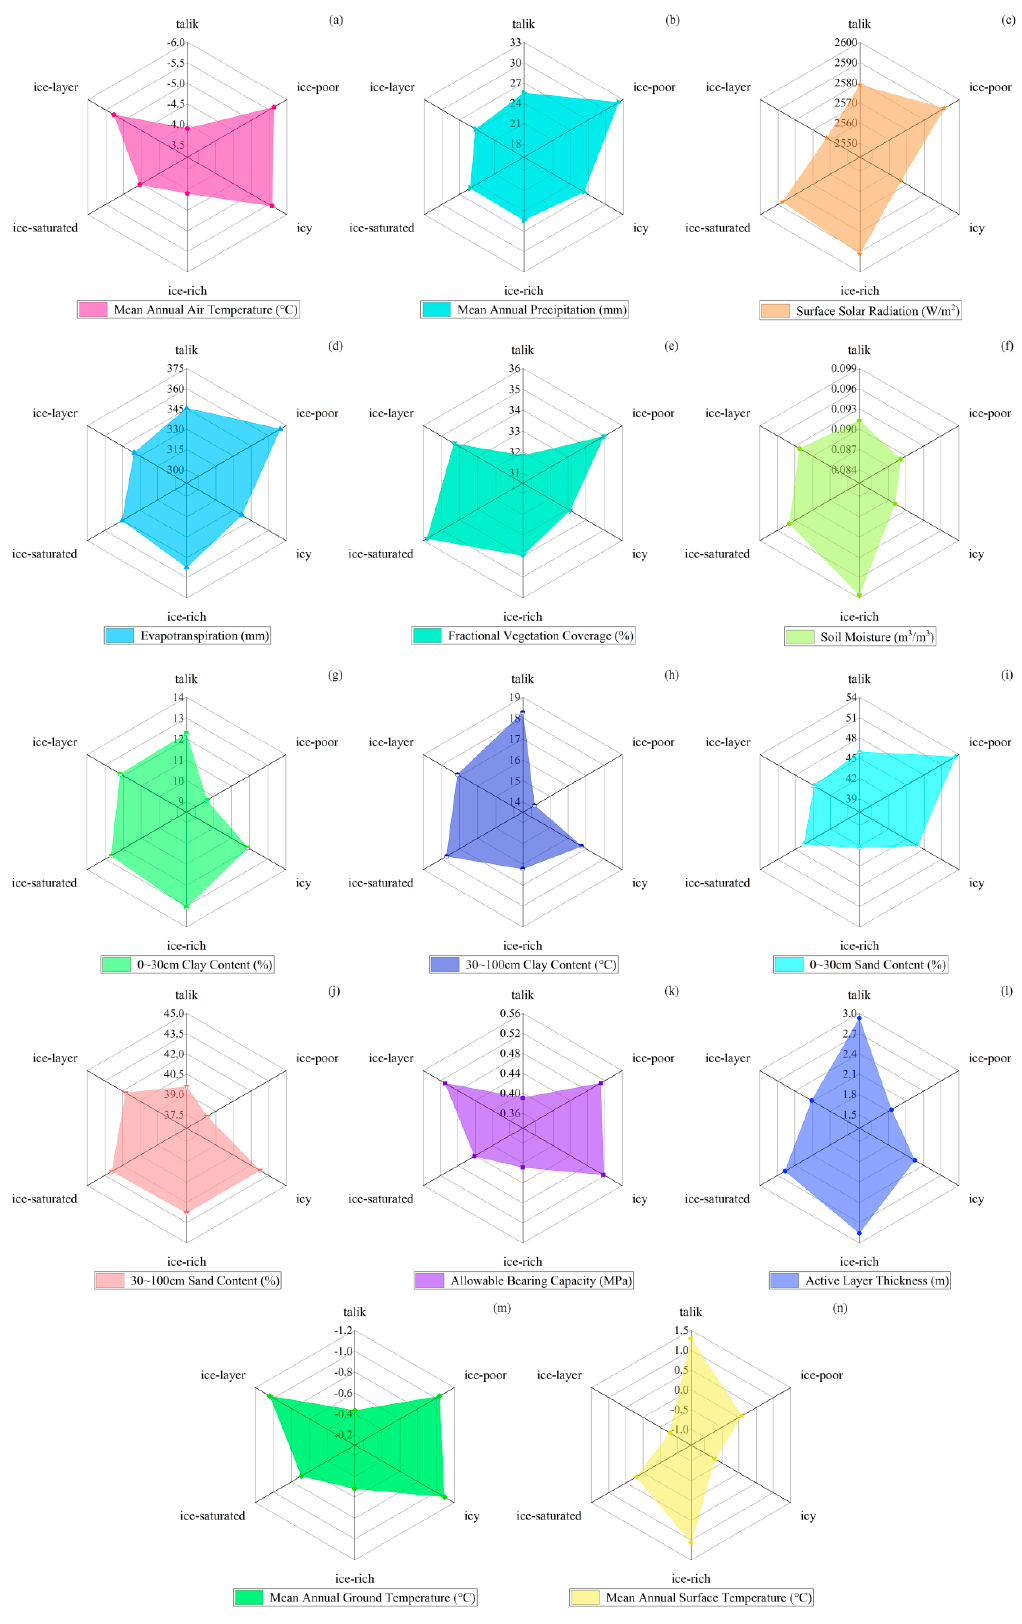
Figure 9. The variation distribution of each risk factor considering VIC: ( a ) MAAT; ( b ) MAP; ( c ) SR; ( d ) ET; ( e ) FVC; ( f ) SM; ( g ) CC1; ( h ) CC2; ( i ) SC1; ( j ) SC2; ( k ) ABC; ( l ) ALT; ( m ) MAGT; ( n ) MAST.